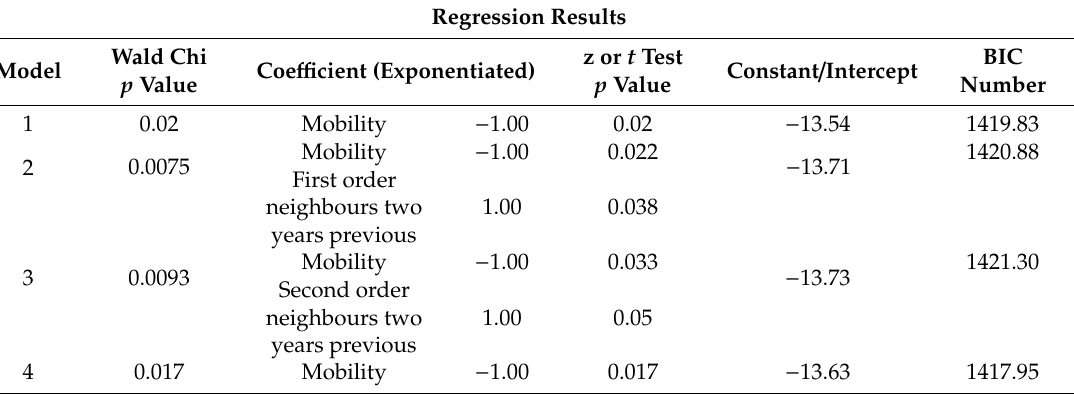
Table 2. Summary of four final candidate model regression outputs (rounded to two significant figures). 174 province-year observations